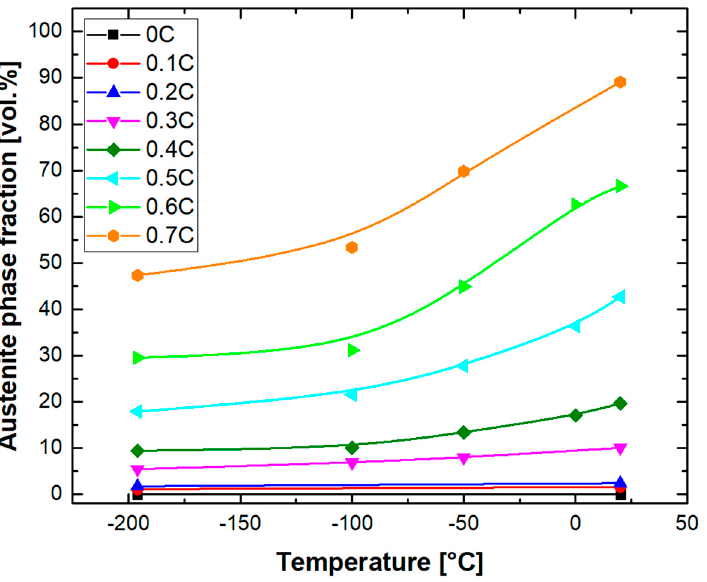
Figure 9. Austenite phase fraction as a function of quench temperature determined by MSAT meas- Figure 9. urements.